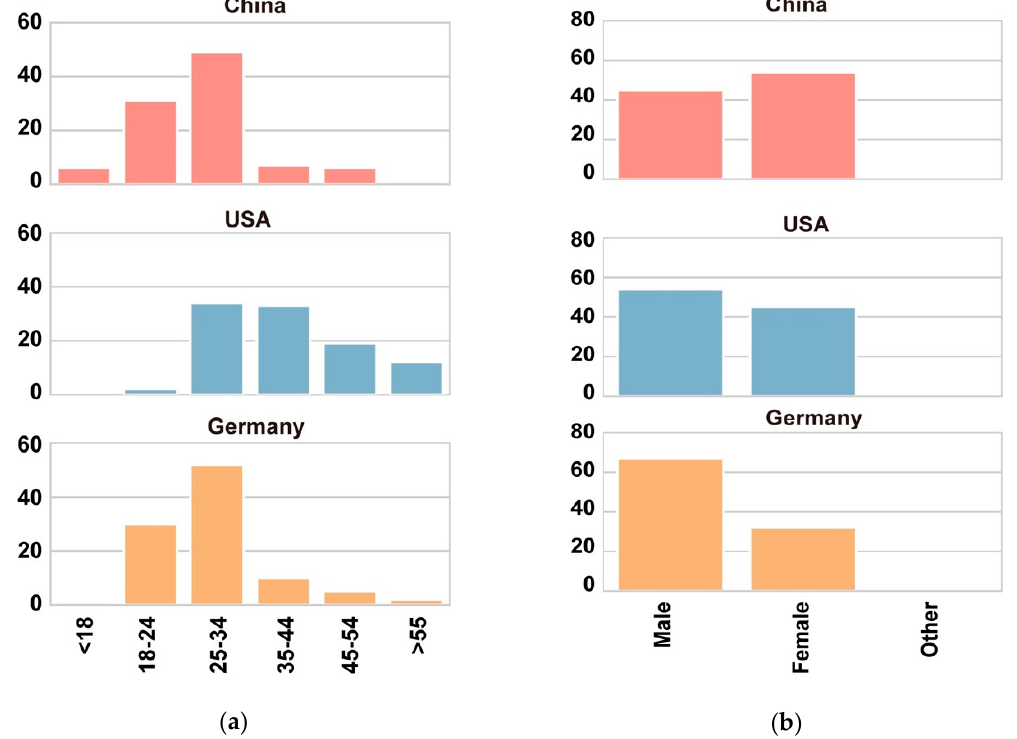
Figure 2. Study participants’ demographics. ( a ) Age distribution of participants from each country. ( b ) Gender distribution of participants from each country.